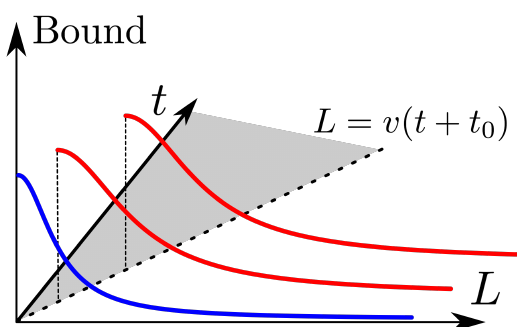
Figure 1: This sketch shows in red the bound (right-hand side of Eq. (8)) over the spatiotemporal plane outside of the light cone. One notices that its scale is different from the initial correlation depicted in blue (Eq. (2)), however, the decay exponent is identical. The inside of the light cone is marked by the grey area and is basically